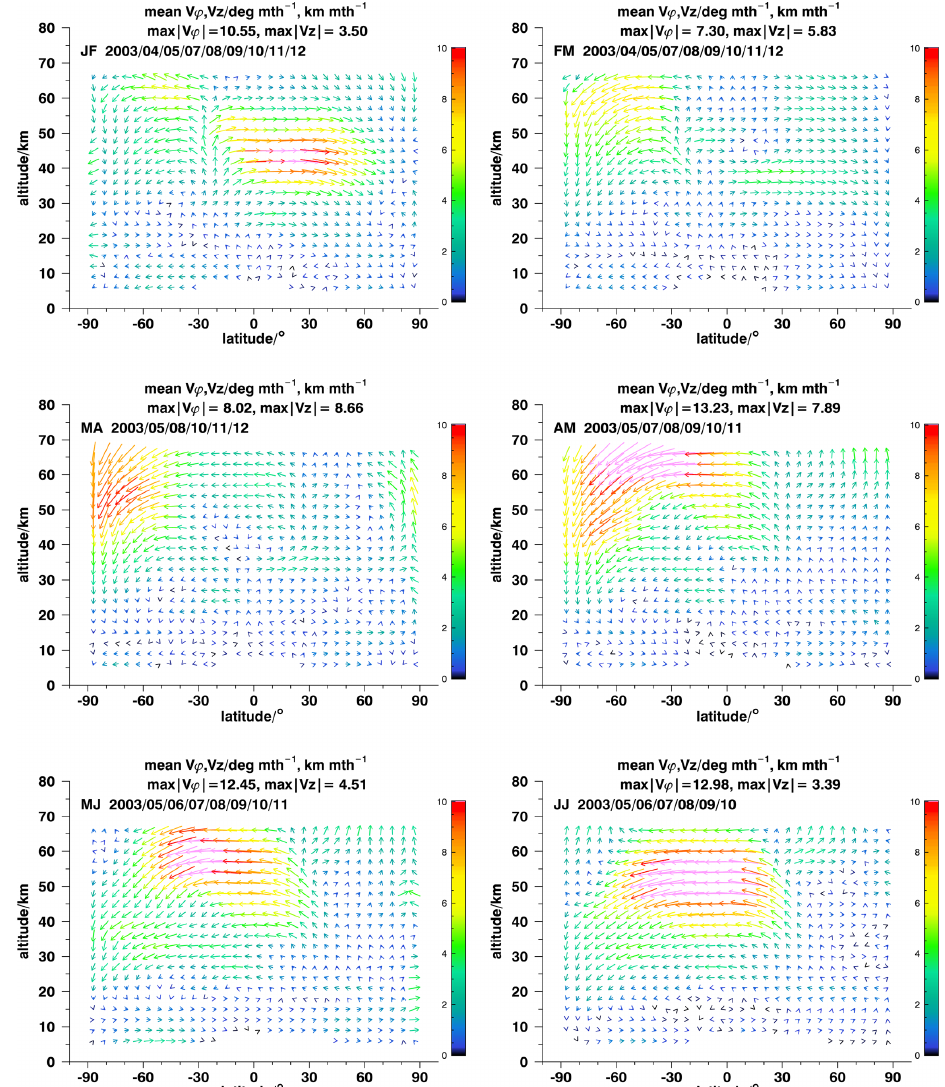
Figure 1. Mean monthly circulation patterns from January–February (top left, JF) to June–July (bottom right, JJ). The headers give quanti- tative information about maximal effective velocities and the months and years considered. Missing years are due to MIPAS data gaps and (cid:113) (v φ degree − 1 month ) 2 + (v z km − 1 month ) 2 for v φ and v z in units of degree per month non-converged inversions. The color scales refer to and kilometer per month. Pink arrows refer to velocities higher than representable by the color scale